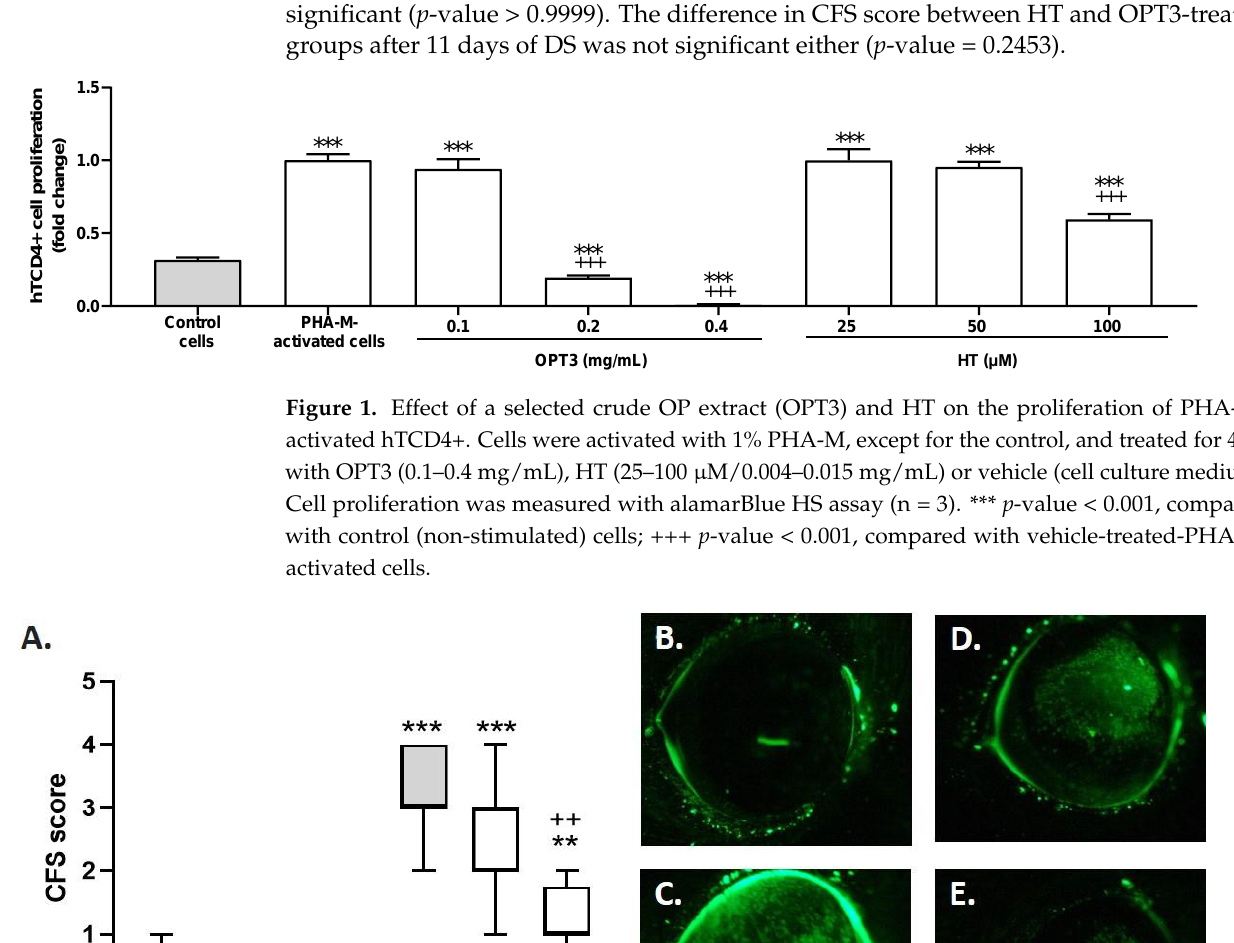
Figure 1. Effect of a selected crude OP extract (OPT3) and HT on the proliferation of PHA-M–acti- vated hTCD4+. Cells were activated with 1% PHA-M, except for the control, and treated for 48 h with OPT3 (0.1–0.4 mg/mL), HT (25–100 μM/0.004–0.015 mg/mL) or vehicle (cell culture medium). Cell proliferation was measured with alamarBlue HS assay (n = 3). *** p -value < 0.001, compared with control (non-stimulated) cells; +++ p -value < 0.001, compared with vehicle-treated-PHA-M-ac- tivated cells.